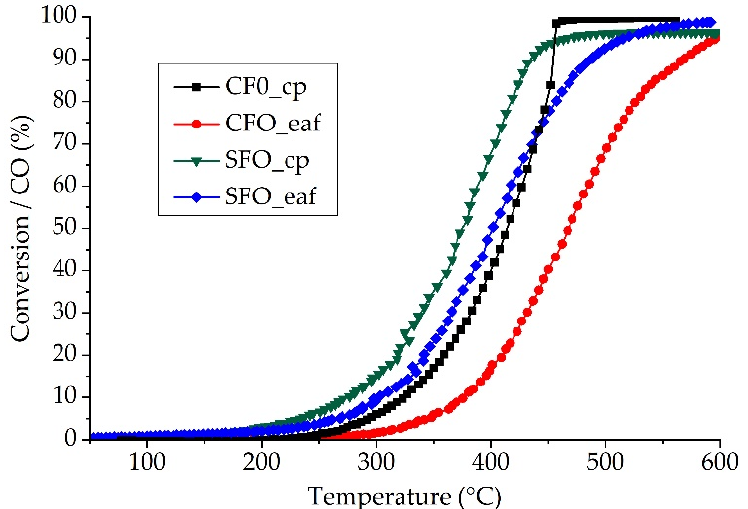
Figure 2. CO oxidation of CFO and SFO synthesized by complexation and fusion synthesis. For